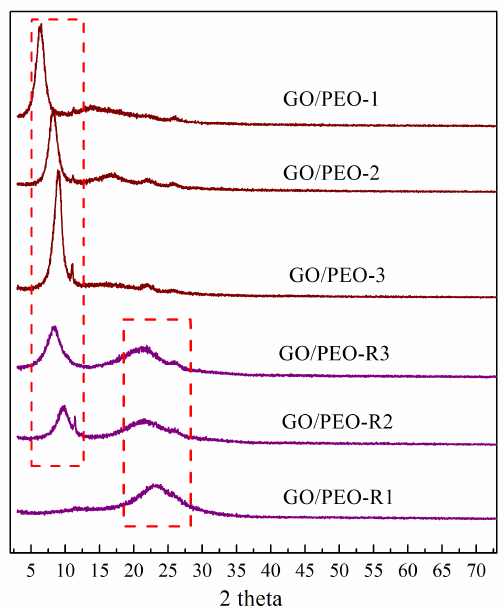
Figure 5. Raman spectra of the films.